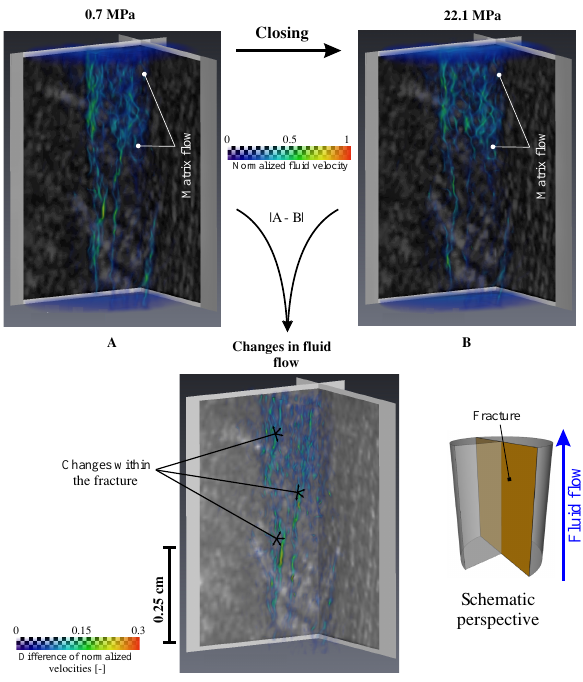
Figure 6. Changes in 3-D fluid flow sample due to closing (A and B) during loading conditions (from 0.7 to 22.1MPa) by applying forward modeling with an EFV method to solve Navier–Stokes– Brinkman. Flow visualizations comprise fracture as well as matrix flow. Fluid flow is visualized by fluid velocity per voxel normalized by the maximum fluid velocity at the given pressure stage. Fluid velocity increases from purple to red. Absolute changes in fluid flow ( | A − B | ) are shown in the lower part. Most changes occur within the fracture. Absolute changes increase from purple to red. A schematic perspective is included for better 3-D